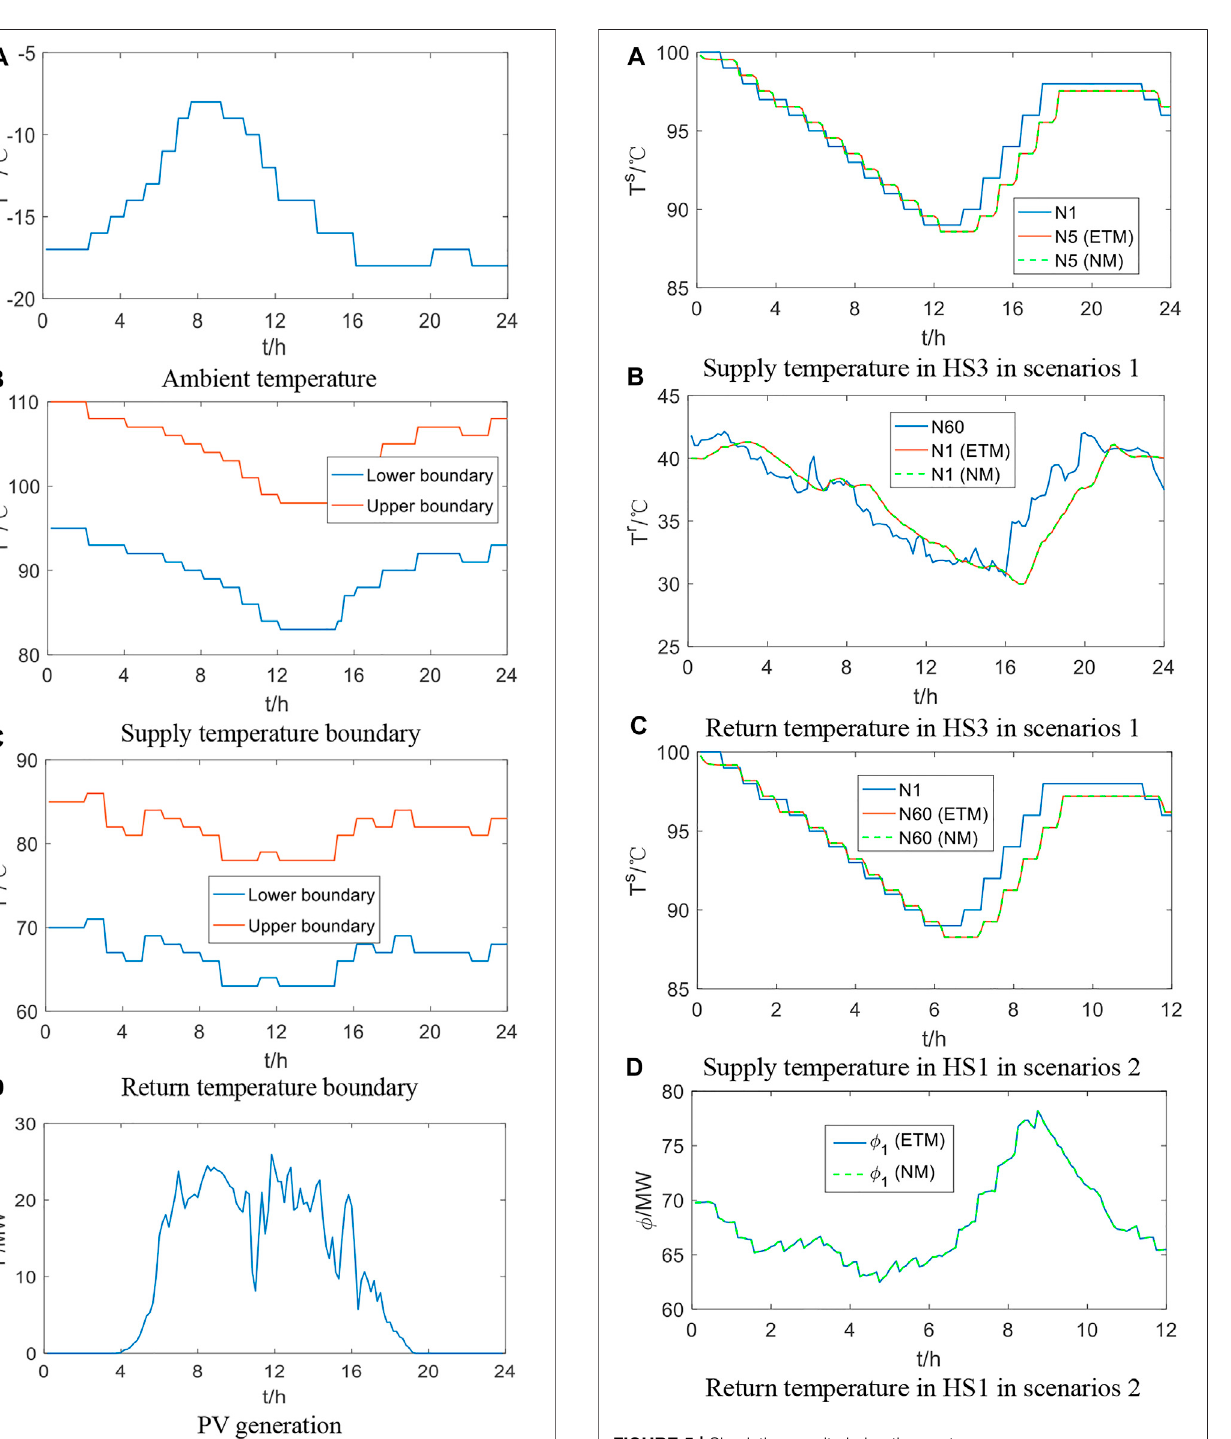
FIGURE 5 | Simulation results in heating